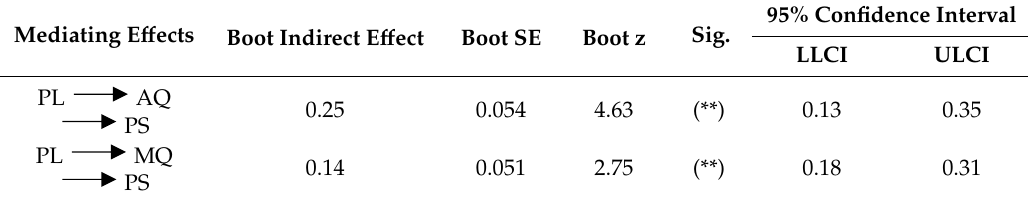
Figure 1. Mediation effects using SEM. ** p < 0.01, NS: Non significant Table 5. Bootstrapping analysis for indirect effects.